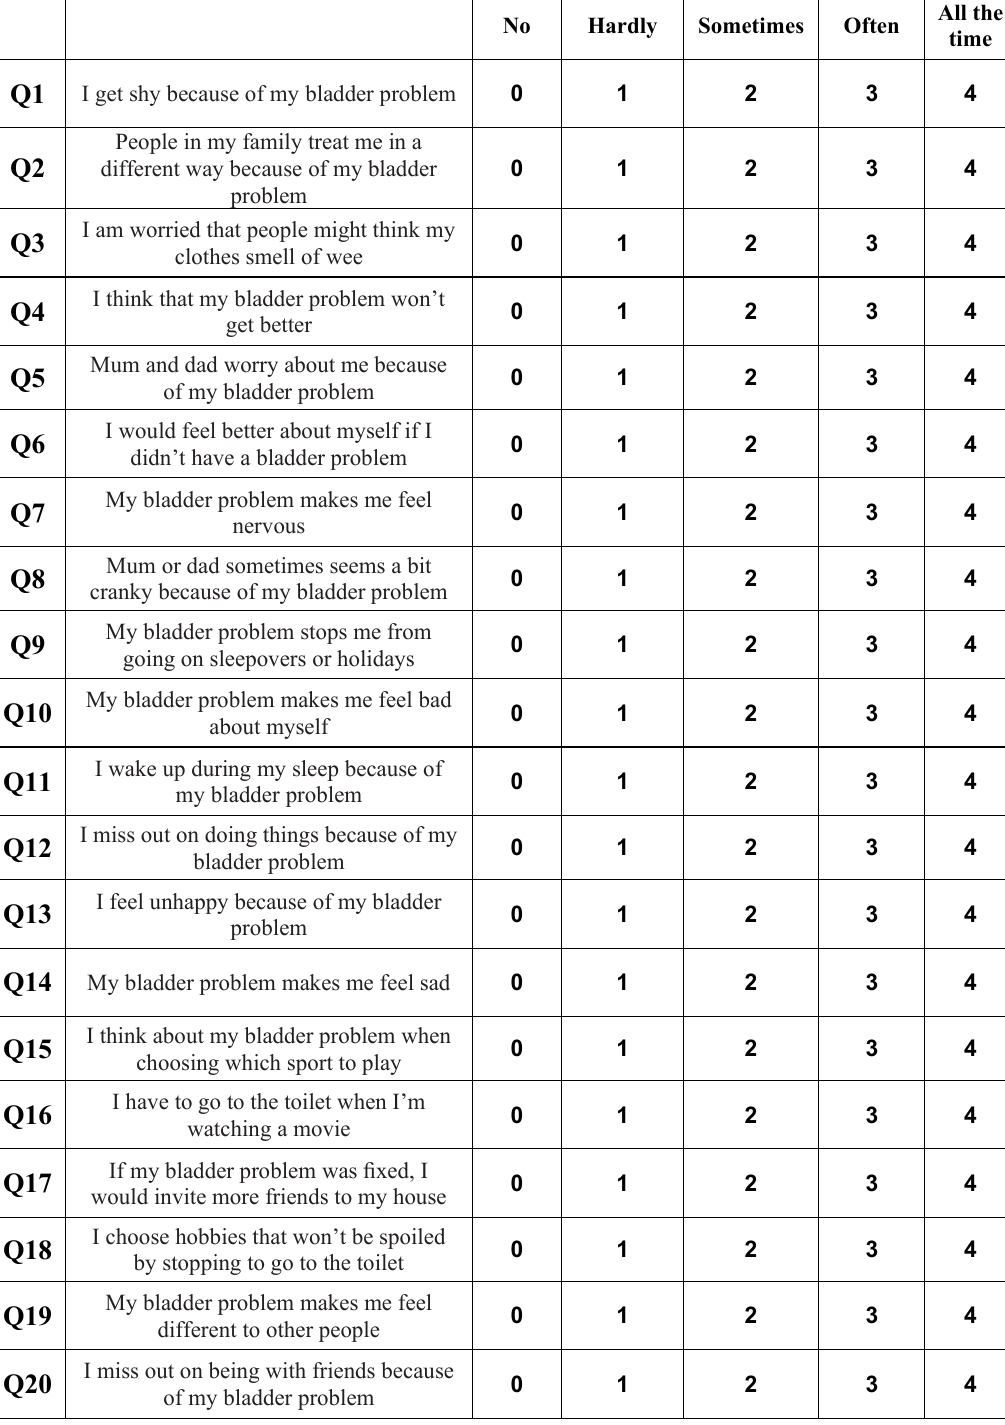
Figure 2 - The Pediatric Incontinence Questionnaire (PINQ) form for